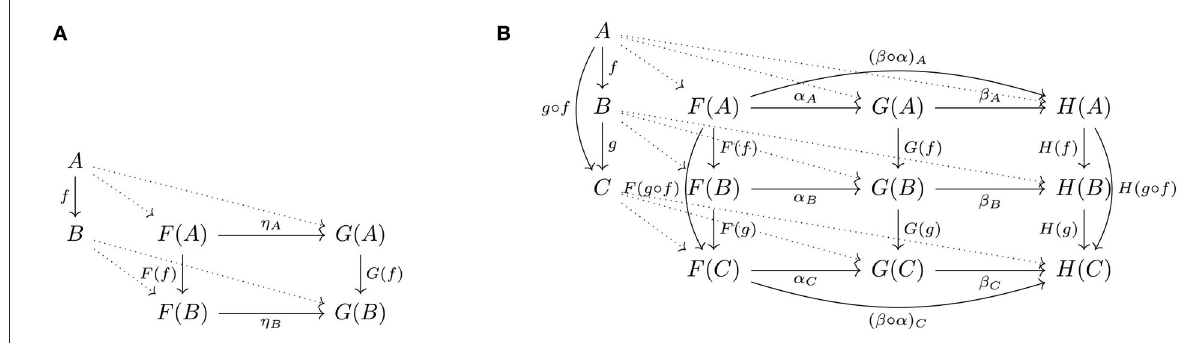
FIGURE2 Natural transformations of (A) arrows and (B) compositions of arrows.